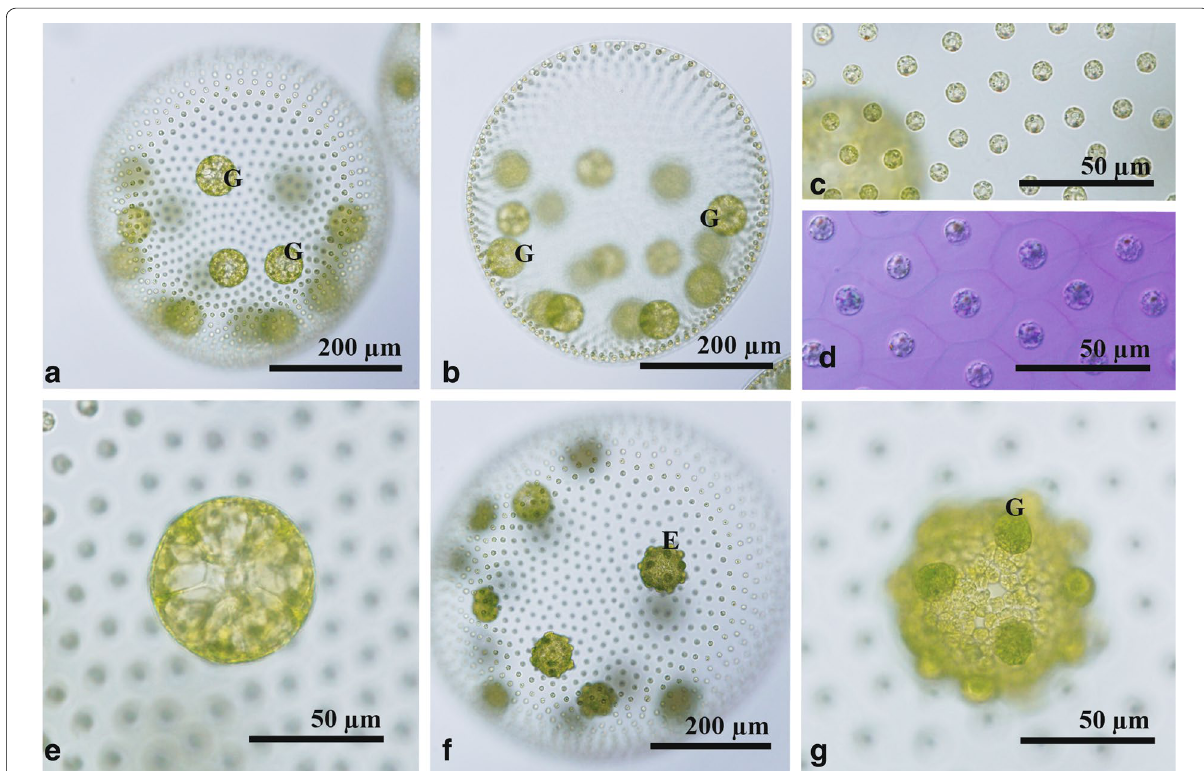
Fig. 1 Light microscopy of asexual spheroids in Taiwanese strains of Volvox carteri f. nagariensis . a Surface view of a spheroid showing undivided gonidia (G). 2016‑tw‑nuk‑6‑1. b Optical section of a spheroid in ( a ) with gonidia (G). c Surface view of spheroid. Note no cytoplasmic bridges between somatic cells. 2016‑tw‑nuk‑6‑1. d Surface view of spheroid showing individual sheaths of the gelatinous matrix. Stained with methylene blue. 2016‑tw‑nuk‑8‑1. e Optical section of gonidium. 2016‑tw‑nuk‑6‑1. f , g Pre‑inversion plakea or embryo (E) showing gonidia (G) of the next